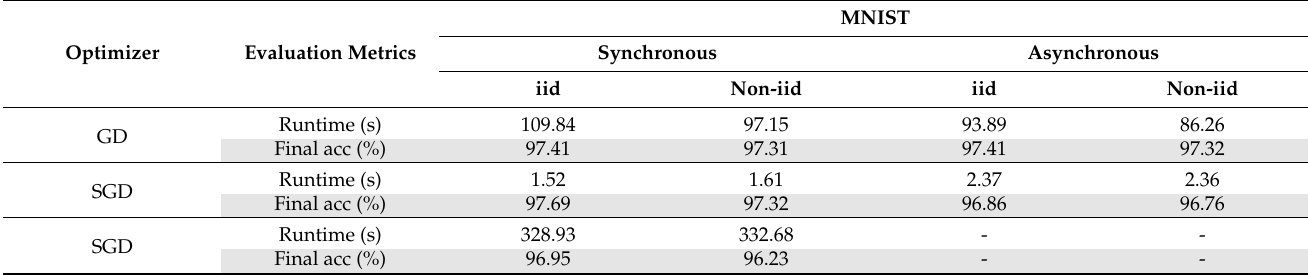
Table 7. Performance analysis of FedSVM With MNIST